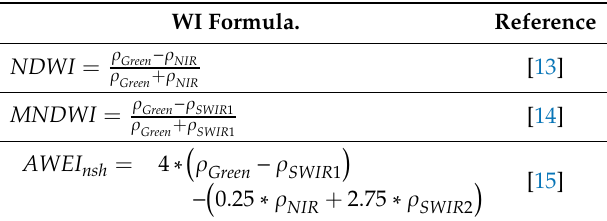
Table 2. Equations of the three water indexes (WIs) used in this study. 𝜌 in the equations represents Top-of-Atmosphere (TOA) reflectance of corresponding Sentinel-2 bands, e.g., 𝜌 (cid:3015)(cid:3010)(cid:3019) is the TOA value of Sentinel-2 near-infrared band.